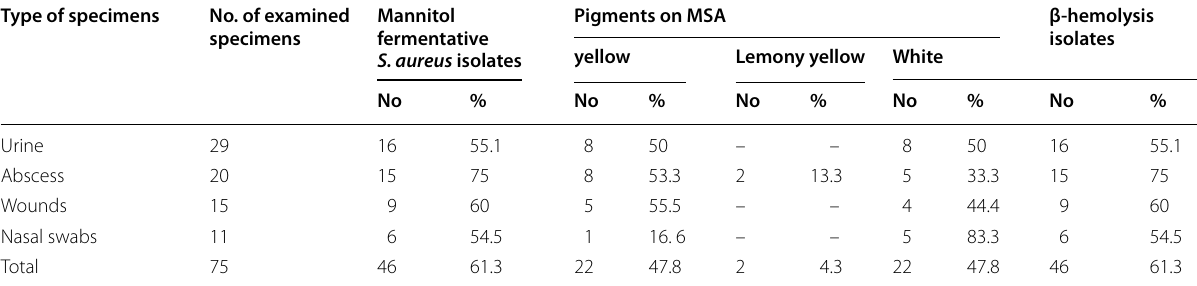
Table 2 Frequency of Staphylococcus aureus isolates among clinical specimens Type of specimens